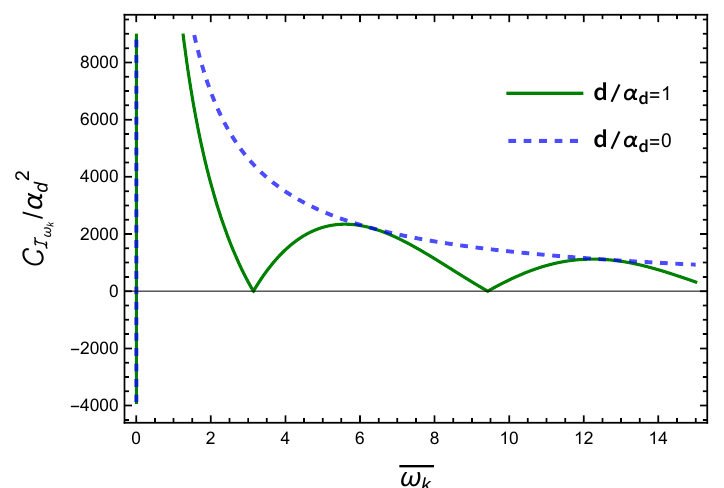
, signifying the concurrence, is plotted for two outgoing null Figure 20 . The quantity C I /α 2 d ωk detectors in a (1 + 3) dimensional de Sitter spacetime with respect to the dimensionless frequency of the field ω = ω for fixed dimensionless detector transition energy ∆ E = ∆ E α k k α d fixed d/α = 0 and d/α = 1 respectively. We considered k d d